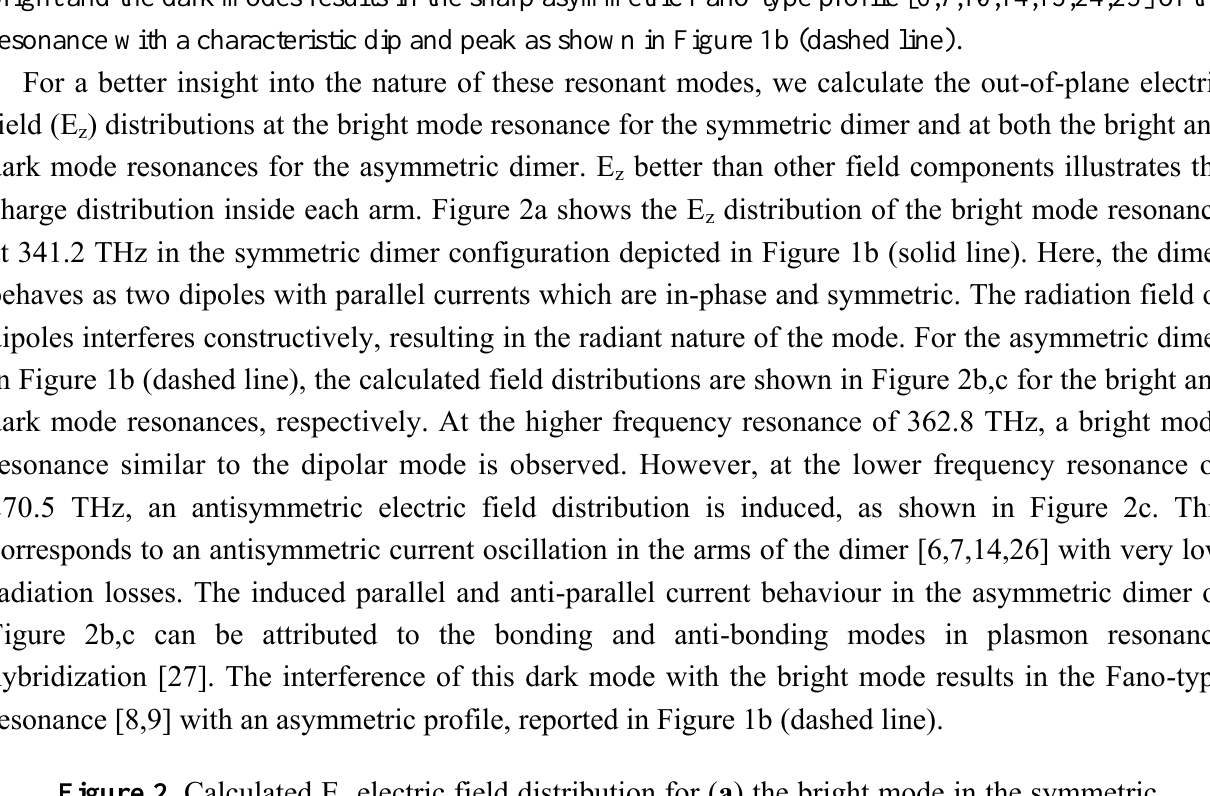
Figure 2. Calculated E electric field distribution for ( a ) the bright mode in the symmetric z dimer at 341.2 THz, the bright ( b ) and the dark ( c ) modes in the asymmetric dimer at 362.8 and 270.5 THz